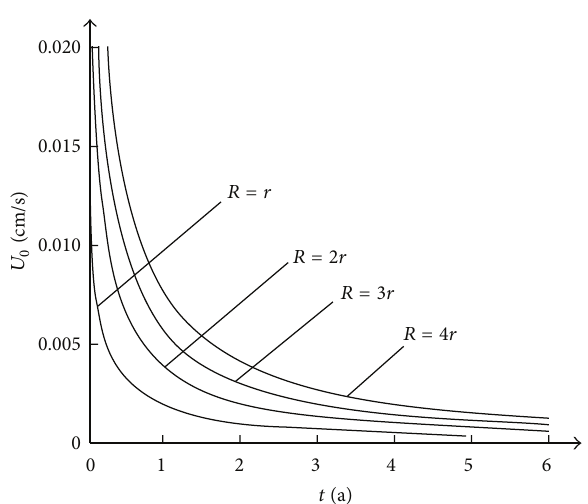
Figure 7: Melting depth of spheres with different radius while Γ 𝑠 = 1 a.